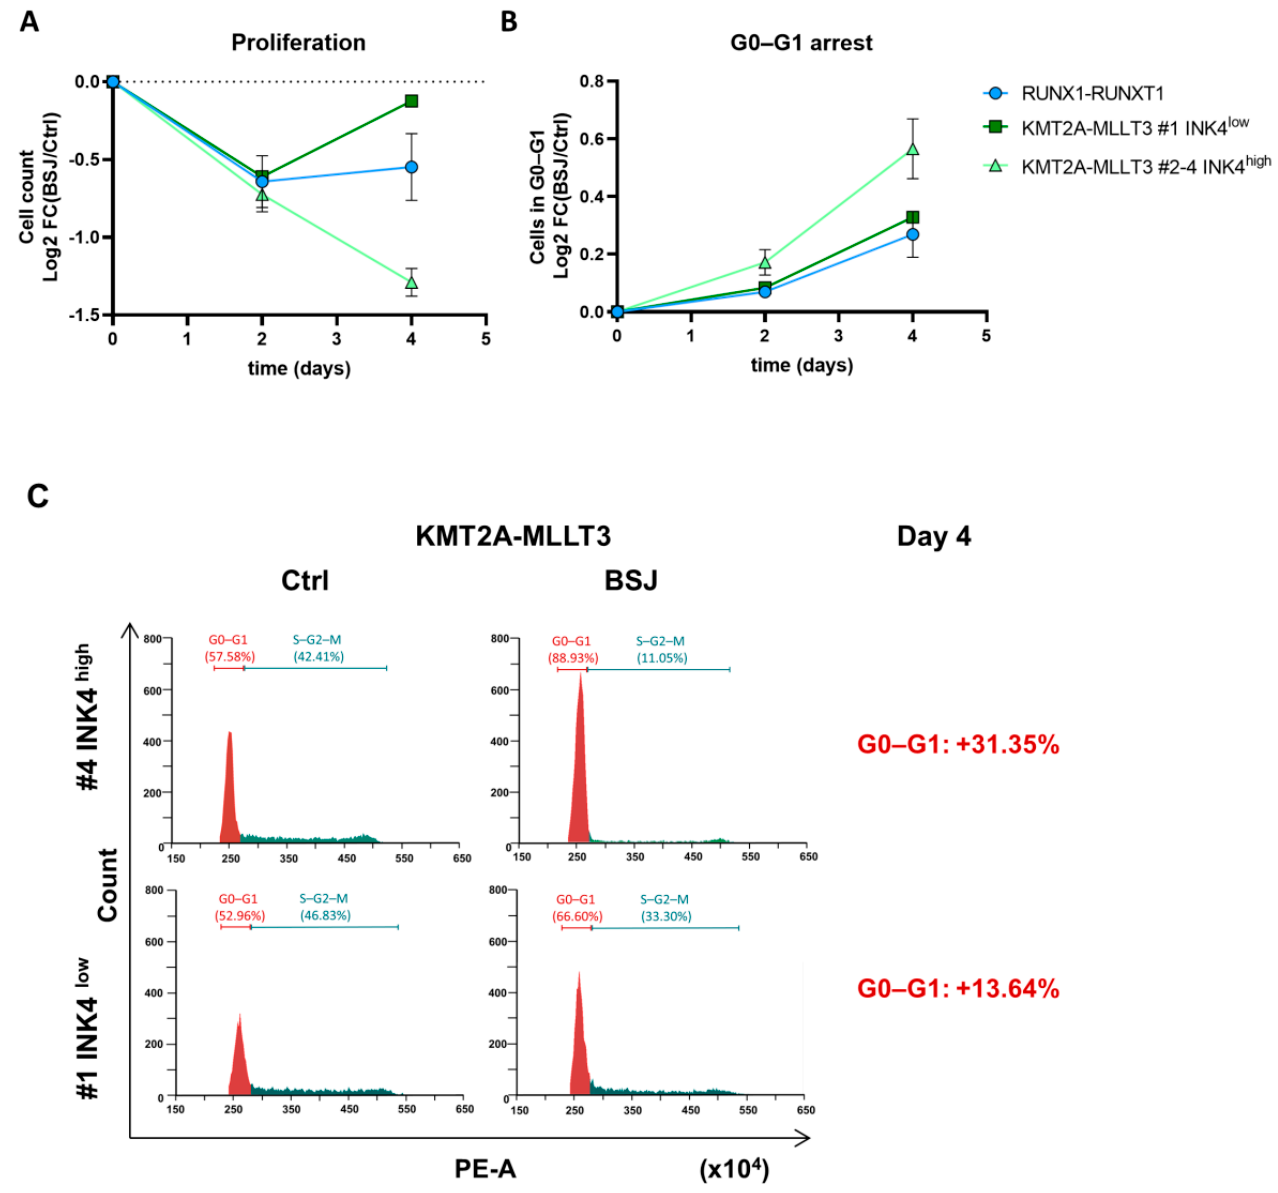
Figure 2. Delayed cell cycle re-entry in AML cells with high INK4 levels after BSJ treatment. ( A ) The flow cytometry analysis of RUNX1-RUNX1T1+ ( n = 3), KMT2A-MLLT3+ INK4 low ( n = 1) and INK4 high ( n = 3) cells. The cell number measurements are depicted as the log2 FC (BSJ/control) calculation after two and four days of treatment with 3 µM of BSJ. ( B ) The flow cytometry analysis of cell cycle phases using propidium iodide (PI). The G0–G1 phase of RUNX1-RUNX1T1+ ( n = 3), KMT2A-MLLT3+ INK4 low ( n = 1) and INK4 high ( n = 3) cells is depicted as the log2 FC (BSJ/control) calculation after two and four days of treatment with 3 µM of BSJ. ( C ) The exemplary cell cycle profiles that were analysed by the PI staining of KMT2A-MLLT3+ #4 INK4 high ( top panel) and #1 INK4 low cells ( bottom panel) at day four of treatment with 3 µM of BSJ (right-hand panel) or vehicle control ( left -hand panel). The gating strategy is indicated in the histogram plots. The change of the percentage of cells in the G0–G1 phase after BSJ treatment is highlighted on the right-hand side of the graphs. Taken together, these data highlight that RUNX1-RUNX1T1+ cells, as well as the KMT2A-MLLT3+ INK4 low line, exhibited a decreased proliferation arrest after CDK6-tar- geted therapy compared to the KMT2A-MLLT3+ INK4 high cells.